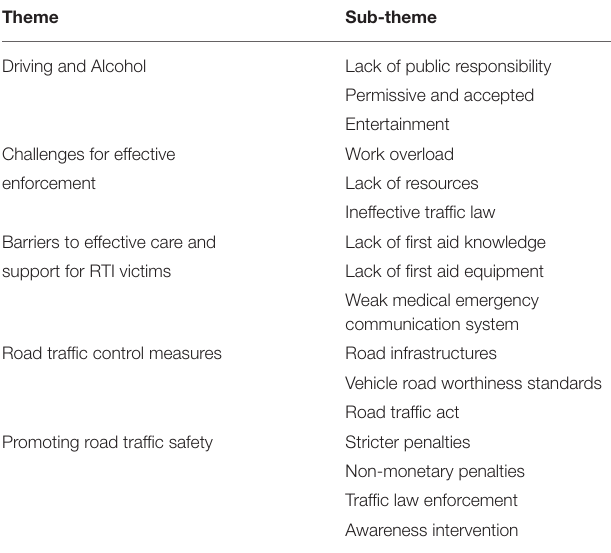
TABLE 2 | Main themes, sub-themes and codes for